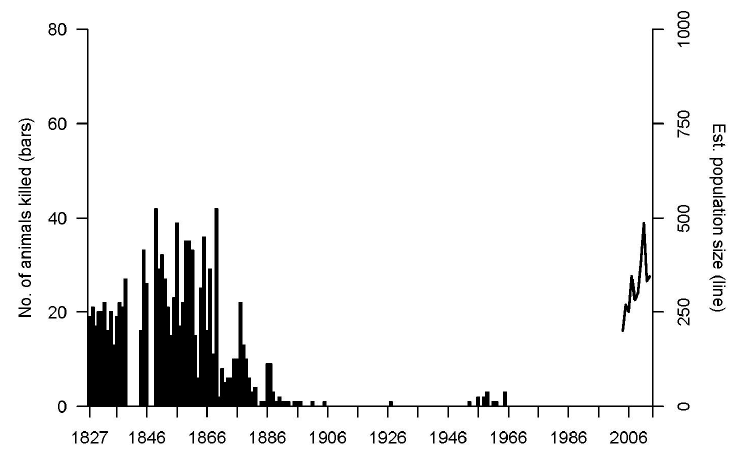
Figure 6. Number of bears killed 1827 to 1965 (no data available for 1840–1843 and 1847–1848) in Jämtland (bars). Estimated population size of bears from 2006–2014 in Jämtland (line). Sources: Swedish National Forest Service and the County Boards of Jämtland. Please note the different scales on the y-axes and that the bounty data end in 1965 and population estimates start in 2006.